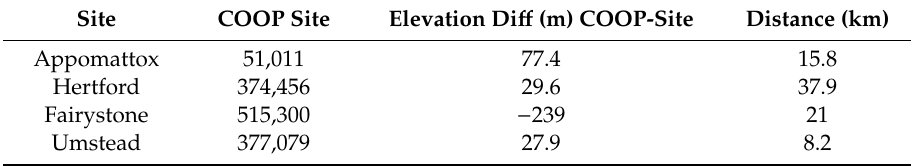
Table 3. Cooperative Observer Program (COOP) sites and proximity to the four LAI research